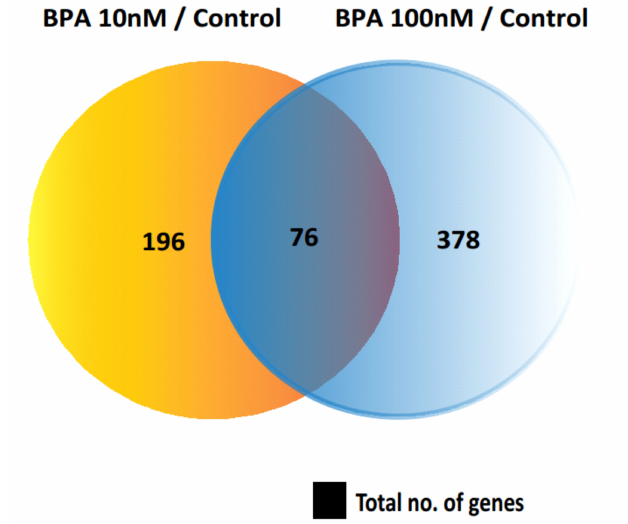
Figure 3. Venn diagram indicates the overlap of differentially expressed genes (DEGs) in cells treated with 10 nM and 100 nM BPA compared with the control group.